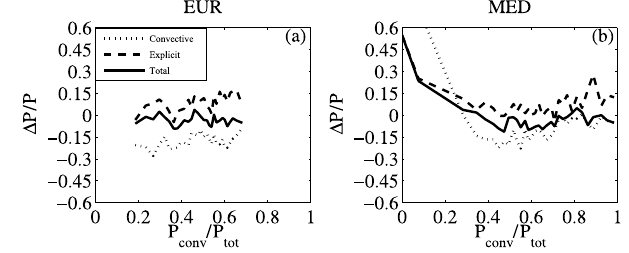
Figure 5. Difference between MAX and MIN simulations of con- vective precipitation ( (cid:49)P conv ) and of surface water mixing ratio ( (cid:49)q ) for EUR (a) and MED (b) domains. The thick black line cor- responds to the ensemble average. The lower and upper dotted lines delimiting the shaded area are the 20th and 80th percentiles, respec-